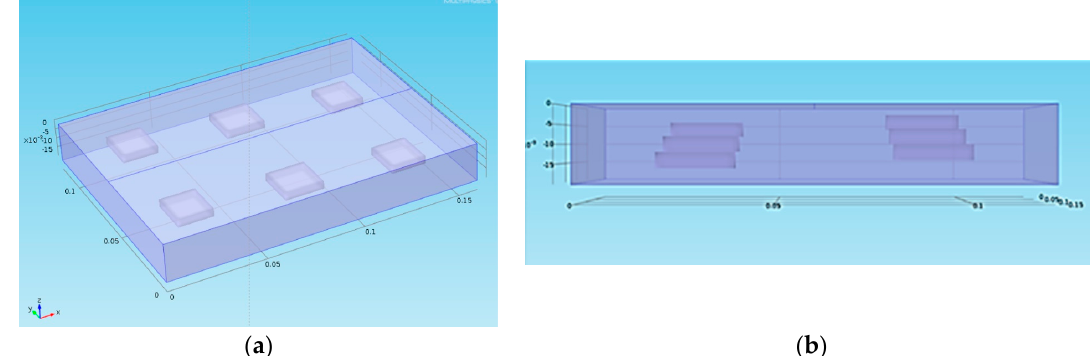
Figure 1. The studied sample: Overview ( a ) and view from the side ( b ) of the theoretically studied sample.